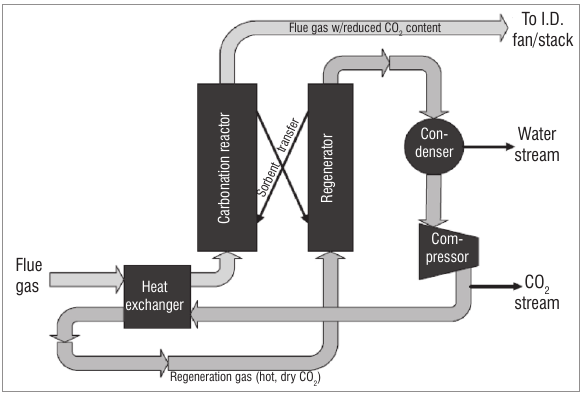
Schematic of the sorbent capture process. 17